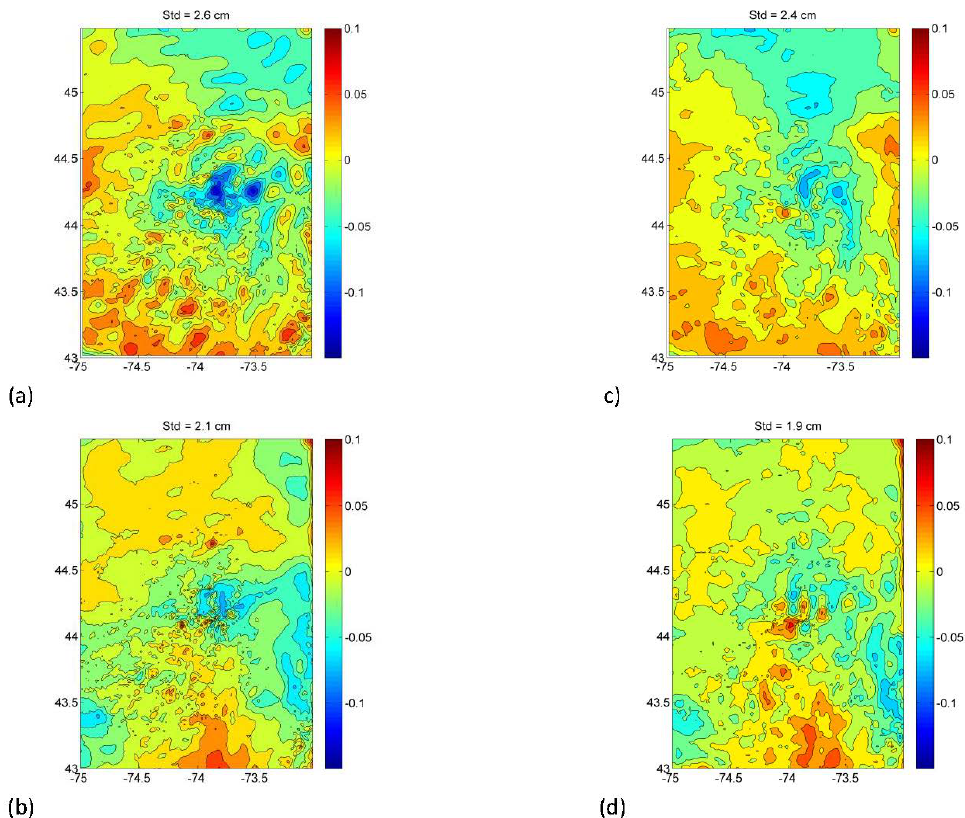
Figure 16: Differences between the airborne and terrestrial gravimetric geoids for the New Hampshire test area in 2 cm contours: (a) dif- ferences between the GMS geoid and the USGG12 geoid; (b) differences between the QGMS geoid and the USGG12 geoid; (c) differences between the GMS geoid and the CGG13 geoid and (d) differences between the QGMS geoid and the CGG13